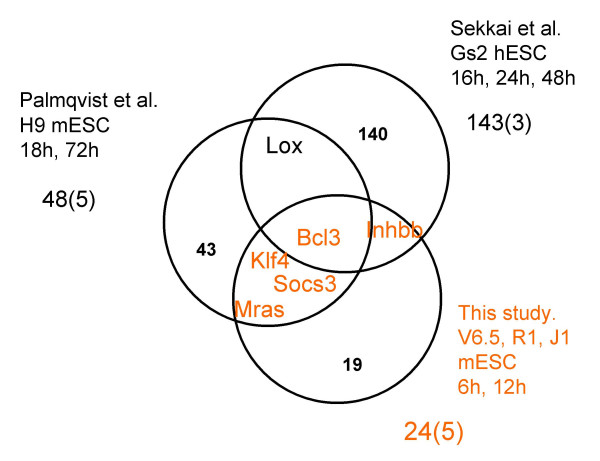
Correspondence between down-regulated genes from this study with two previous studies of mESC differentiation. Venn diagram showing the genes found in at least two studies. We note that the cell lines, conditions, and gene selection procedures for these three studies are very different. Palmqvist et al.: 48 genes from Table 3 in [7]. Sekkai et al.: 143 genes from Table S1 of [6]. This study: 24 genes down-regulated in at least two cell lines at 6 hr or 12 hr.